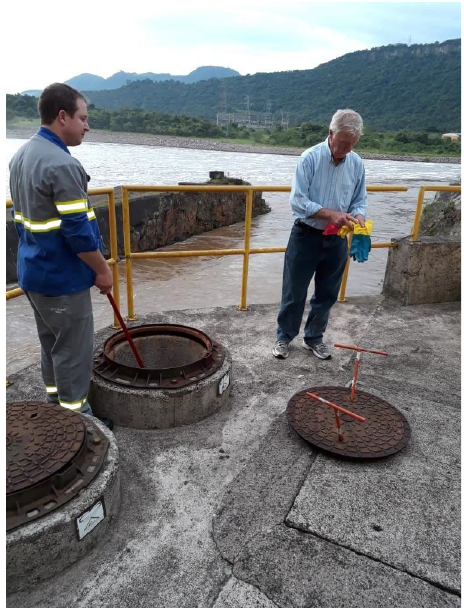
Figure 4. Albano continued to work after his retirement. Here, at Usina Hidrelétrica Dona Francisca, RS (Photo: Margarete